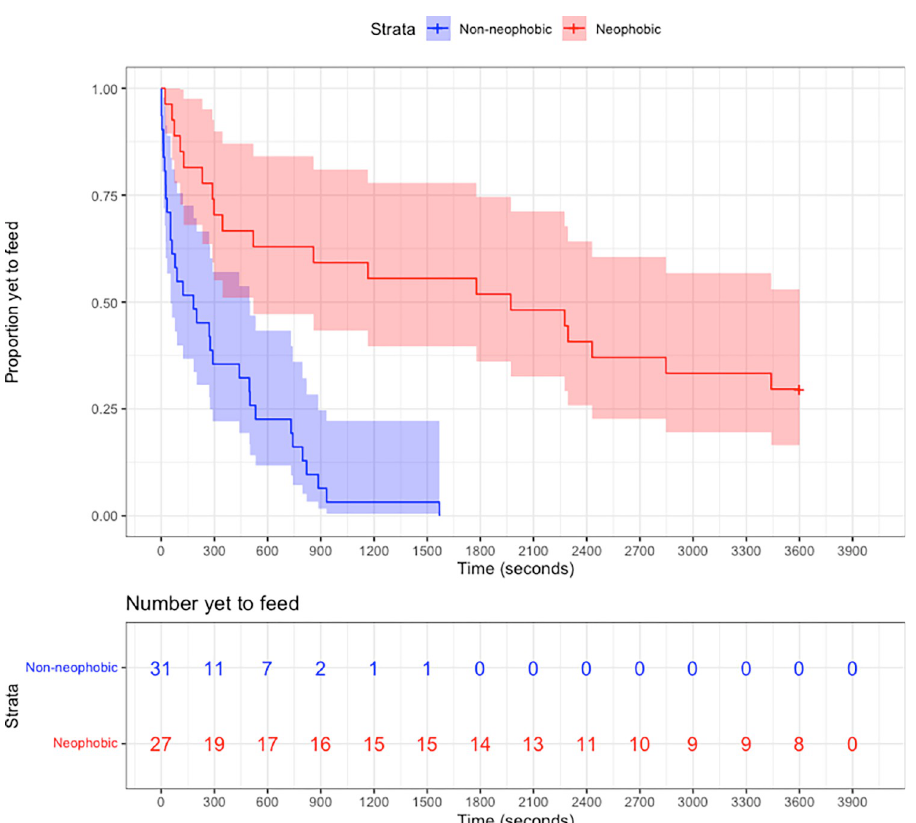
Fig 2. Top: Kaplan-Meier survival curves of house sparrow feeding likelihood in the presence of a novel object. There were four object trials for each bird, except for two missing trials (1 neophobic, 1 non-neophobic) where the video camera malfunctioned. Data are split by neophobia phenotype (not neophobic n = 8, neophobic n = 7) and with 95% confidence intervals. The trial ended at 3600 s. Bottom : Risk table indicating the number of sparrows yet to feed from the dish in 300 s intervals. Both plot and table were created using the ‘survminer’ package in R Studio